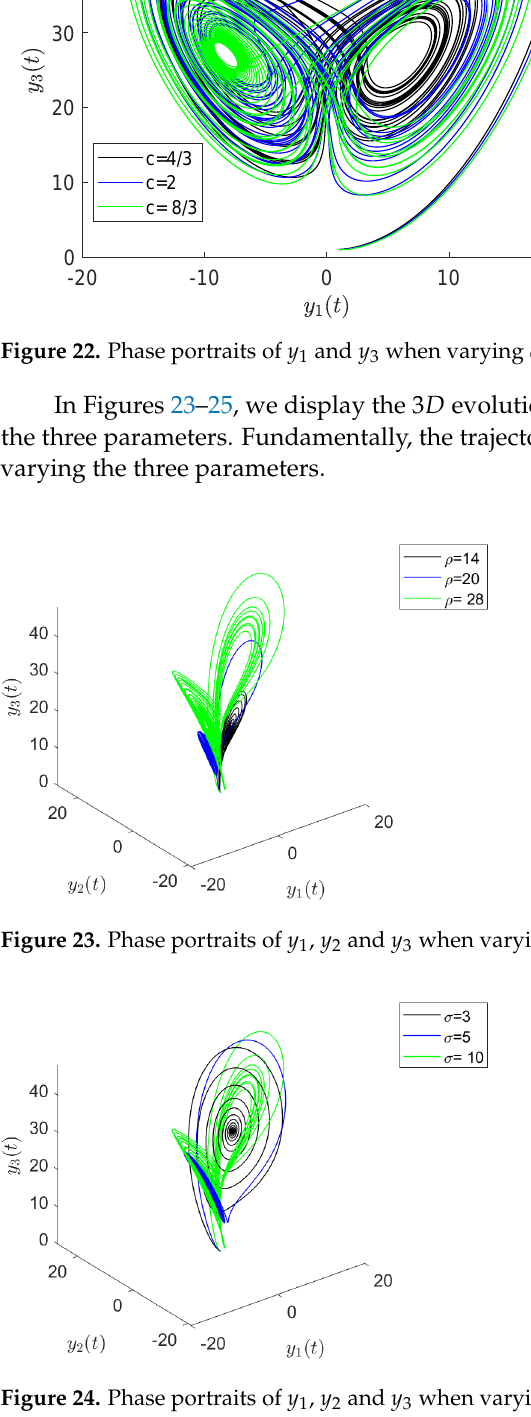
Figure 24. Phase portraits of y 1 , y 2 and y 3 when varying σ